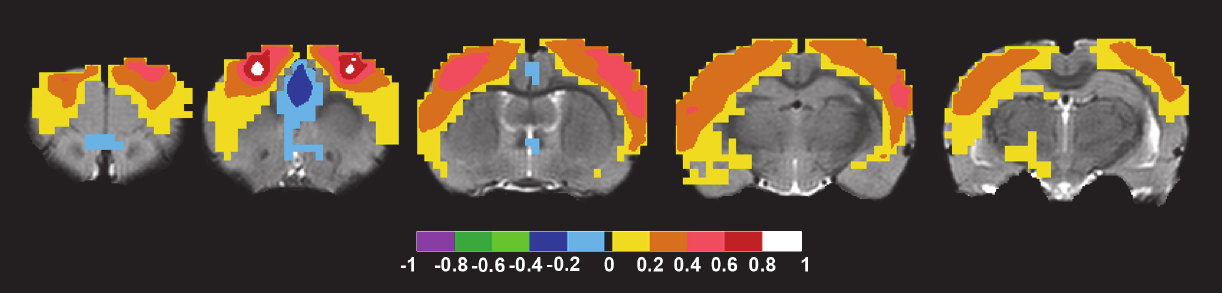
Fig 4. Rat Motor Network. To define the motor-sensory network in the rat brain we placed a bilateral seed in the corresponding part of the brain in the primary motor cortex, approximately Bregma in mm: +/-3.0; 1.5; 1.7. Axial rat brain images are sorted from left to right in rostral to caudal order. The image to the far left shows bilateral positive low FC-values in M1 region and negative correlation values in medial orbital cortex. The second image to the left shows bilateral positive FC-values in M1 as well as S1 and negative FC-values in cingulate gyrus and orbital cortex. The two images to the right show bilateral positive FC-values in M1, S1, and S2. FC-values are displayed with a pseudo-colored scale bar; with increments of 0.2 each designated a color (see the color-bar in the